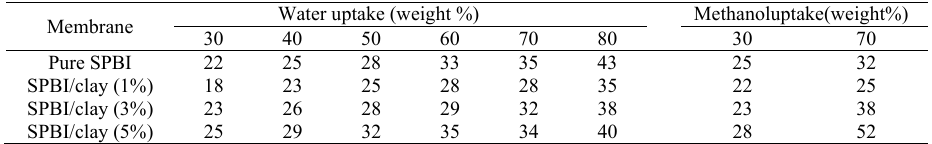
Table 3. Water and methanol uptake of crosslinked SPBI and cross-linked SPBI/clay nanocomposite membranes as a function of temperature. Membrane